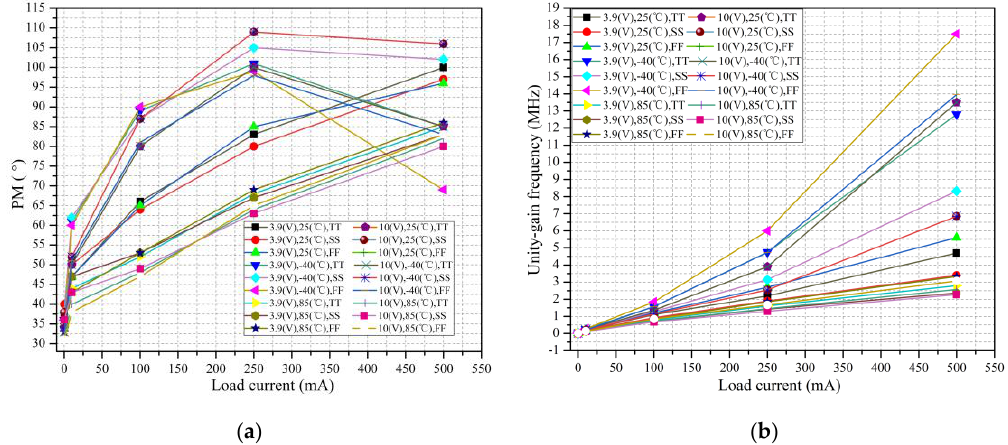
Figure 7. The simulated phase margins (PMs) and unity gain frequency with different cases; ( a ) PMs; ( b ) unity gain frequency.